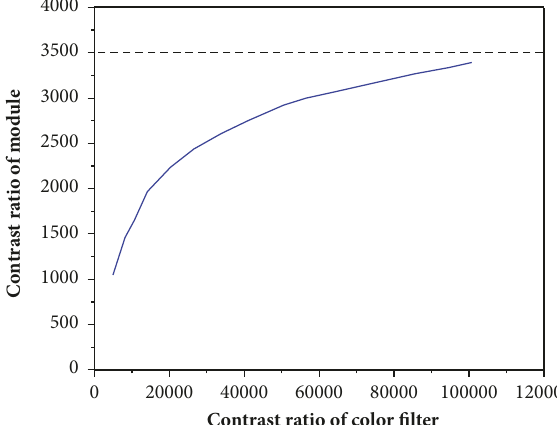
Figure 7: Simulation result for the contrast ratio performance of color filter and